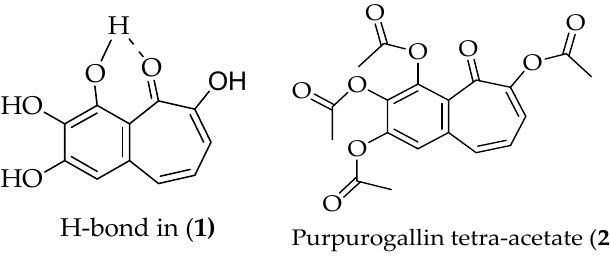
Figure 2. ( a ) Examples of natural benzotropolones fomentariol; ( b ) goupiolone A; ( c ) crocipodin. We have shown that purpurogallin ( 1 ) can be obtained by catalytic oxidation of pyrogallol according to our previous work [13]. Purpurogallin ( 1 ) presents an intramolecular hydrogen bond which makes it difficult to modify the hydroxyl involved in this bond (see Figure 3).